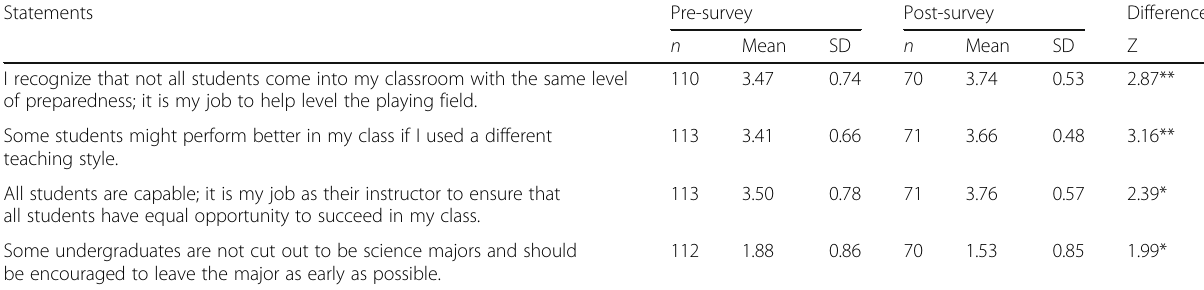
Table 5 Descriptive statistics for survey items probing faculty attitudes about students before and after the workshop